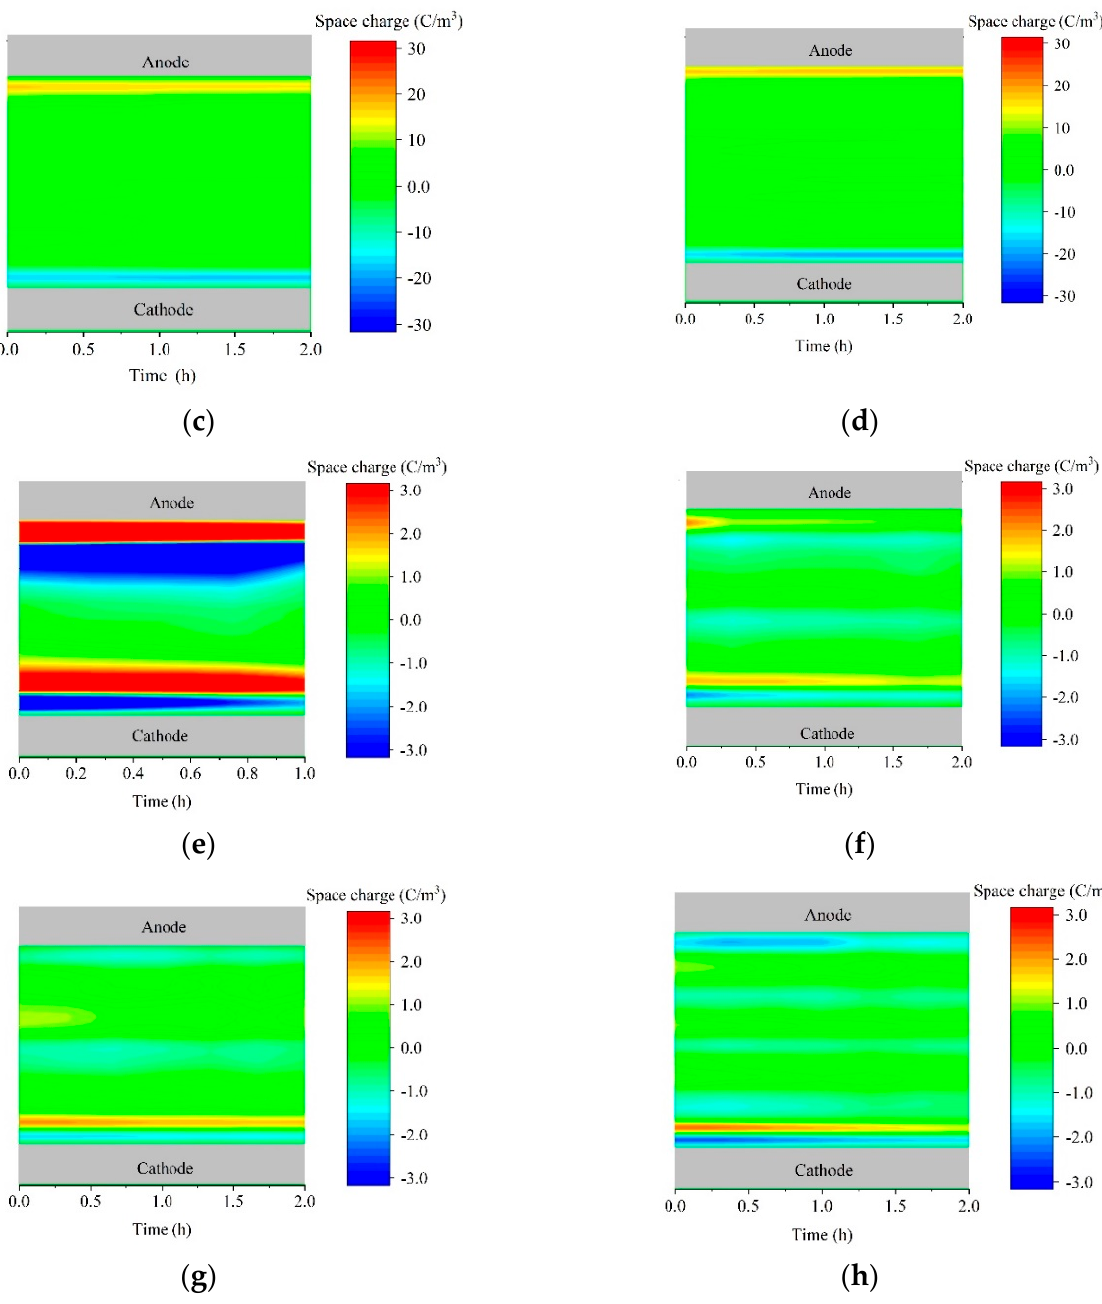
Figure 7. Effect of A-Al 2 O 3 /LDPE on dynamics space charge injection and suppression ( a ) pure LDPE, ( b ) 0.1% A-Al 2 O 3 /LDPE, ( c ) 0.2% A-Al 2 O 3 /LDPE, ( d ) 0.5% A-Al 2 O 3 /LDPE, Dependences of the relaxation time in the decay of total trapped charge in ( e ) pure LDPE, ( f ) 0.1% A-Al 2 O 3 /LDPE, ( g ) 0.2% A-Al 2 O 3 /LDPE, ( h ) 0.5% A-Al 2 O 3 /LDPE under 30 kV/mm upon the electrical field before short circuiting.